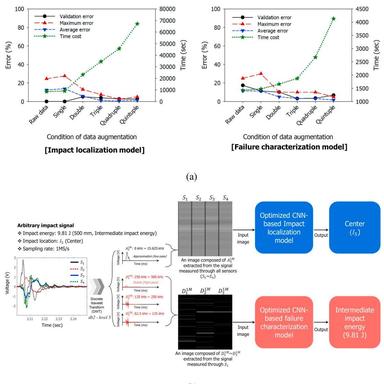
Results for predictive CNN-based model verification: (a) the effects of data augmentation on test error and time cost, and (b) assessment of the practicability of the developed impact characterization algorithm.